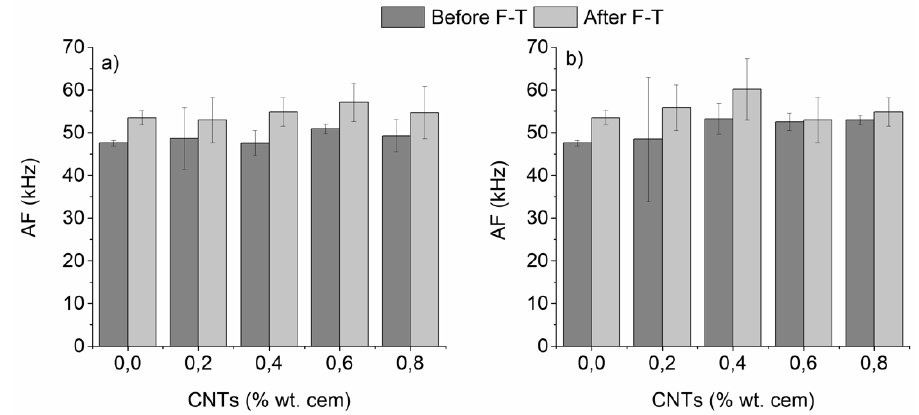
Figure 8. Rise time/amplitude (RA) values of nano-mortars prepared with ( a ) superplasticizer and ( b ) surfactant as a dispersive agent, as a function of F-T exposure (plain specimens have been added for reference).